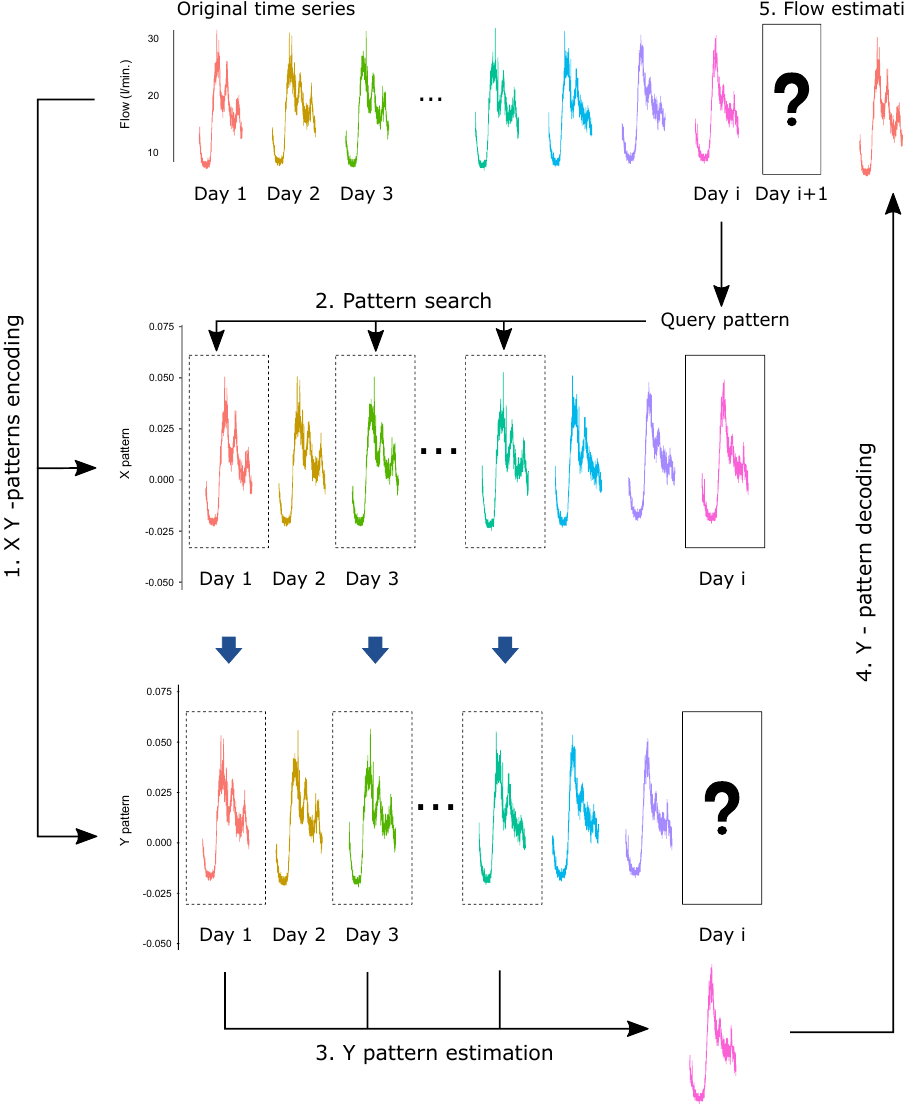
Figure 1. Scheme of the pattern-similarity